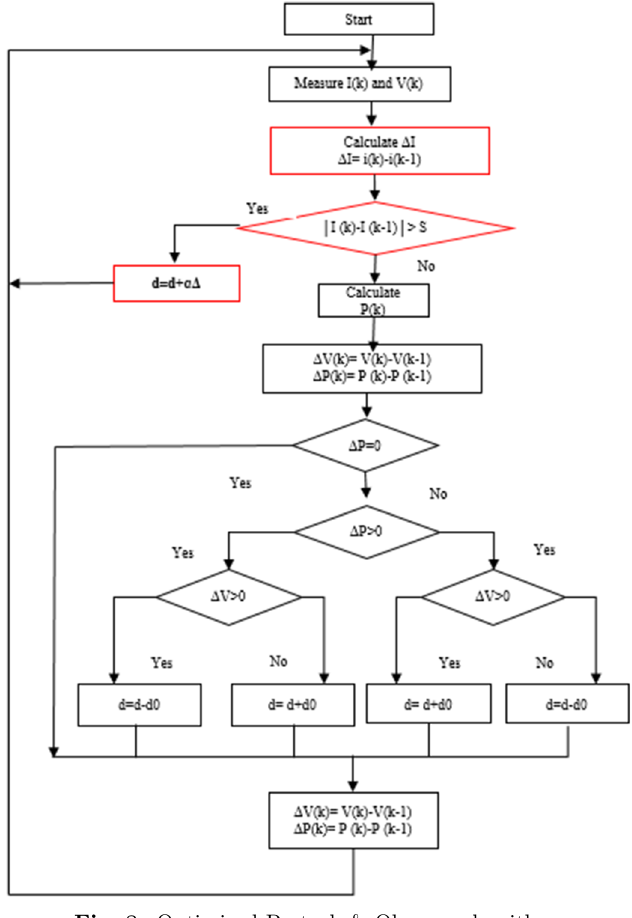
Fig. 8. Optimized Perturb & Observe